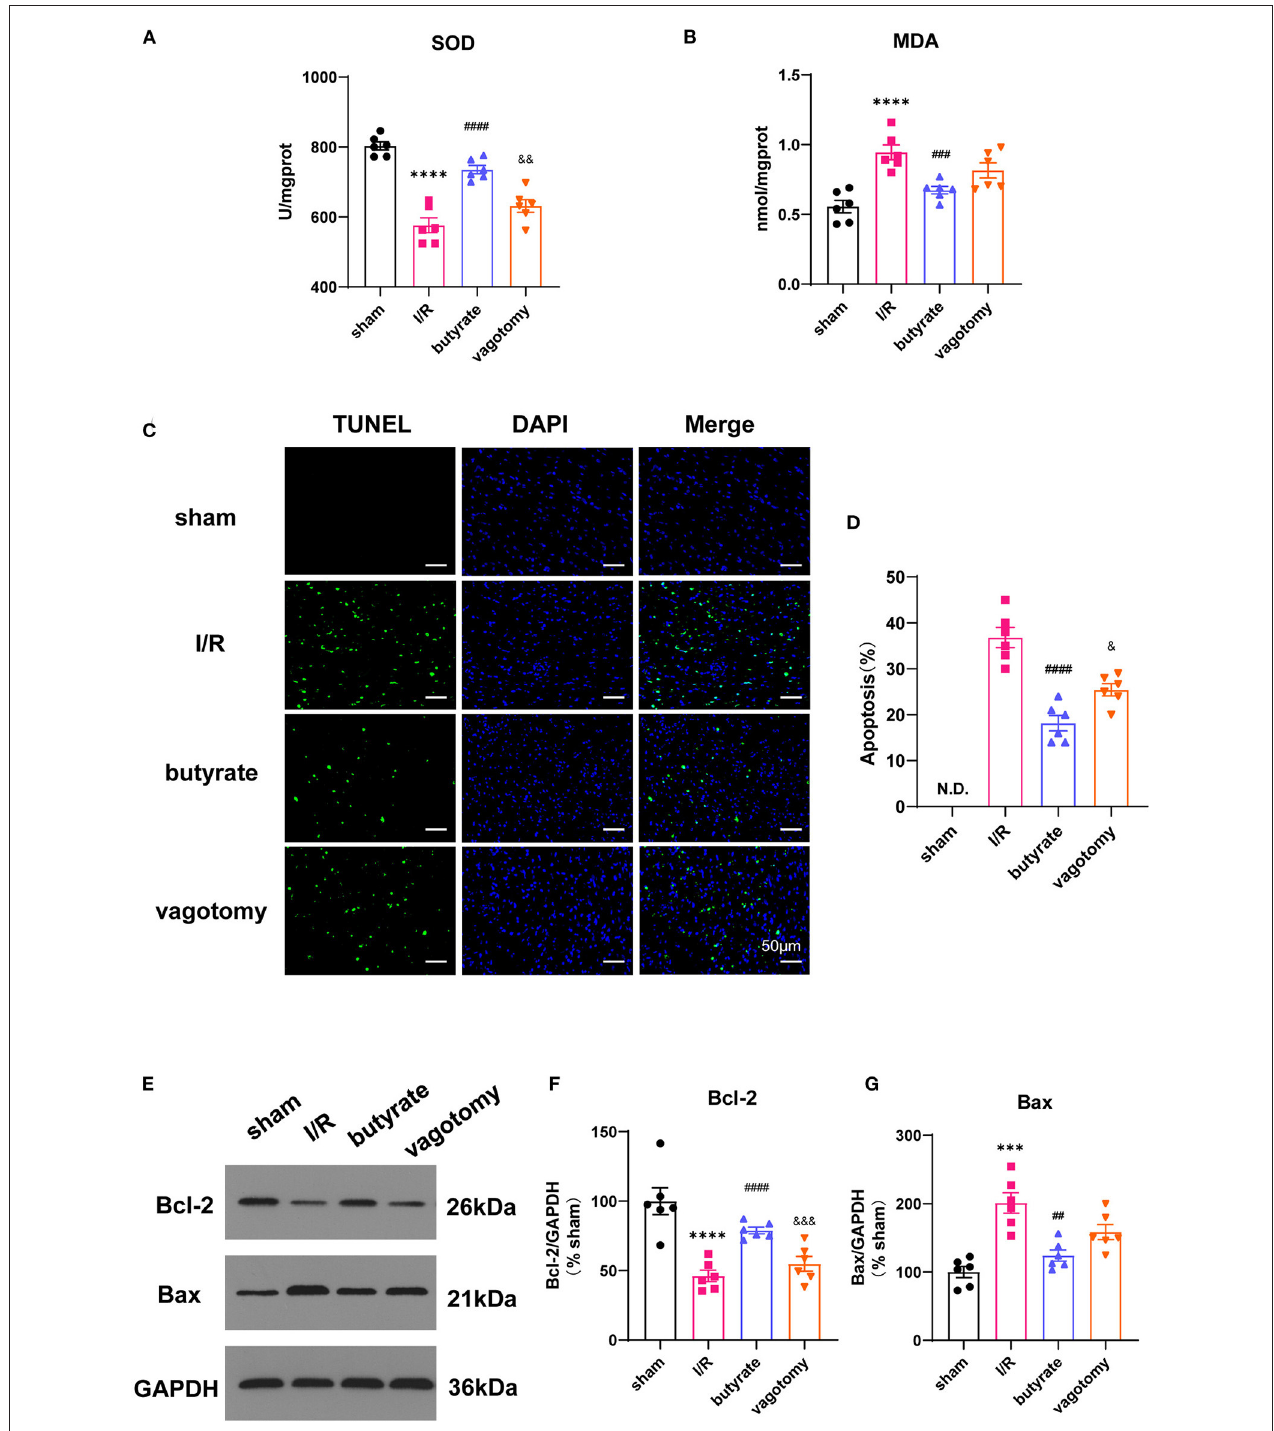
FIGURE 2 | Butyrate treatment improved oxidative stress and cell apoptosis after myocardial I/R, and vagotomy diminished this protective effect. (A) Myocardial MDA and (B) SOD activities. (C) Representative images of TUNEL staining. Myocardial tissues were stained and analyzed with TUNEL (green) and counterstained with DAPI (blue). (D) Quantitative analysis of TUNEL positive cells expressed as percentage of DAPI stained cells. N.D., no detectable. Compared group: I/R, butyrate, vagotomy. (E) Representative images of Western blot of Bax and Bcl-2 expression from sham, I/R, butyrate, and vagotomy groups. (F,G) Relative intensity of Bax/Bcl2 over GAPDH (% sham). *** p < 0.001 vs. sham group, **** p < 0.0001 vs. sham group; ## p < 0.01 vs. I/R group, ### p < 0.001 vs. I/R group, #### p < 0.0001 vs. I/R group; & p < 0.05, && p < 0.01, &&& p < 0.001 vs. butyrate group. SOD, superoxide dismutase; MDA, malondialdehyde; DAPI, 4’,6-diamidino-2-phenylindole; I/R, ischemia/reperfusion; Bcl-2, B-cell lymphoma-2; Bax, BCL2-Associated X; GAPDH, glyceraldehyde-3-phosphate